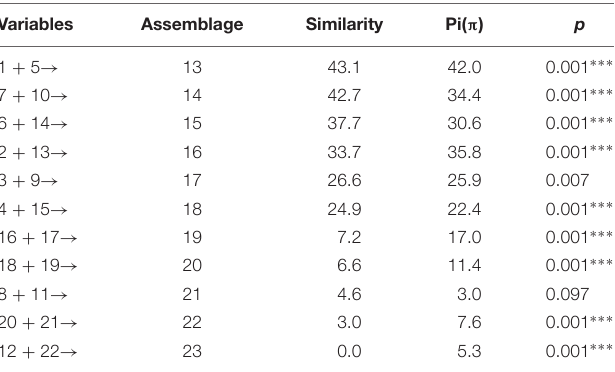
TABLE 1 | SIMPROF-test results including relevant parameters. The results refer to the cluster diagram in Figure 3